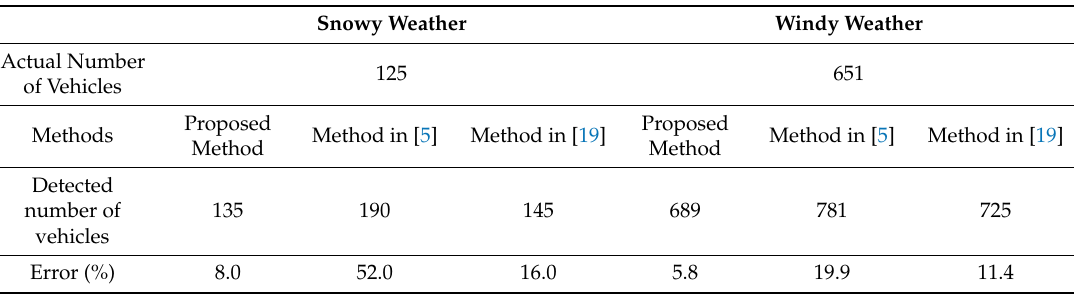
Table 2. Performance